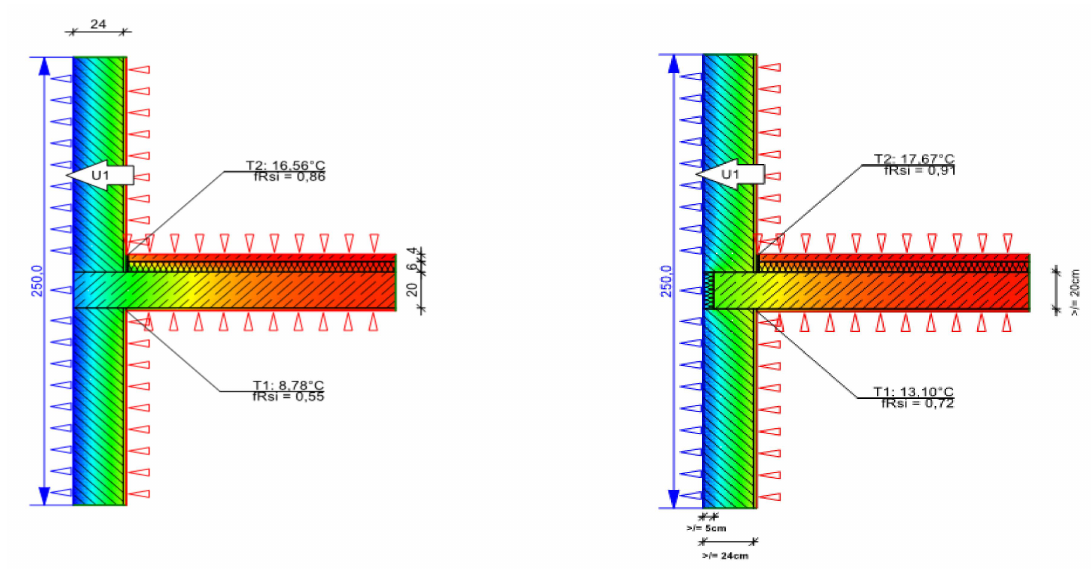
Figure A4. Before and after the thermal bridge retrofit of a floor slab (created with ThermCad thermal bridge simulation